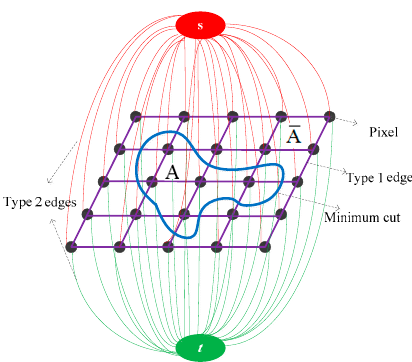
Figure 1. Schematic diagram of GrabCut segmentation.